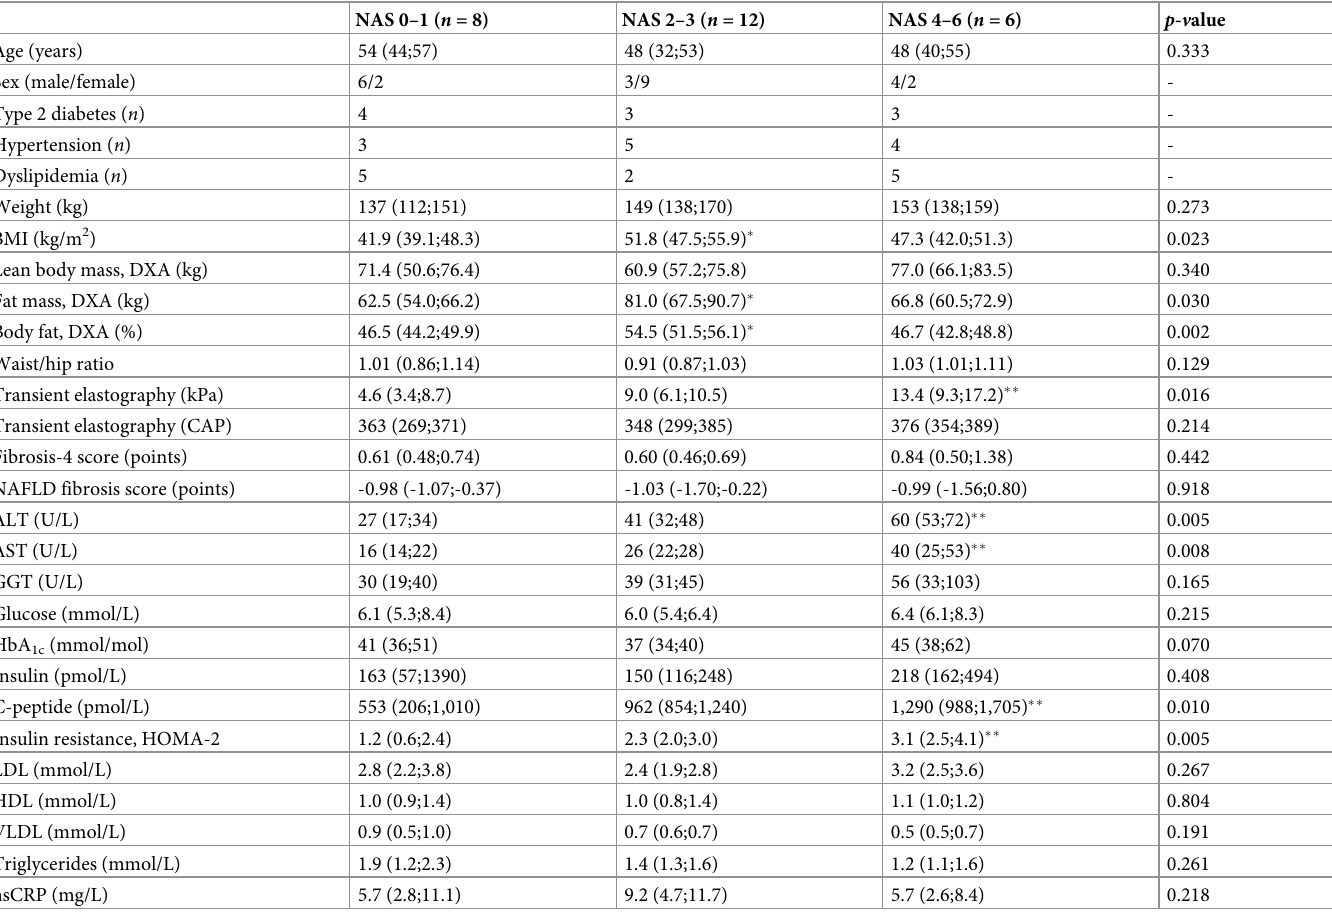
Table 1. Clinical, anthropometrical and biochemical characteristics of study participants divided into three groups with increasing